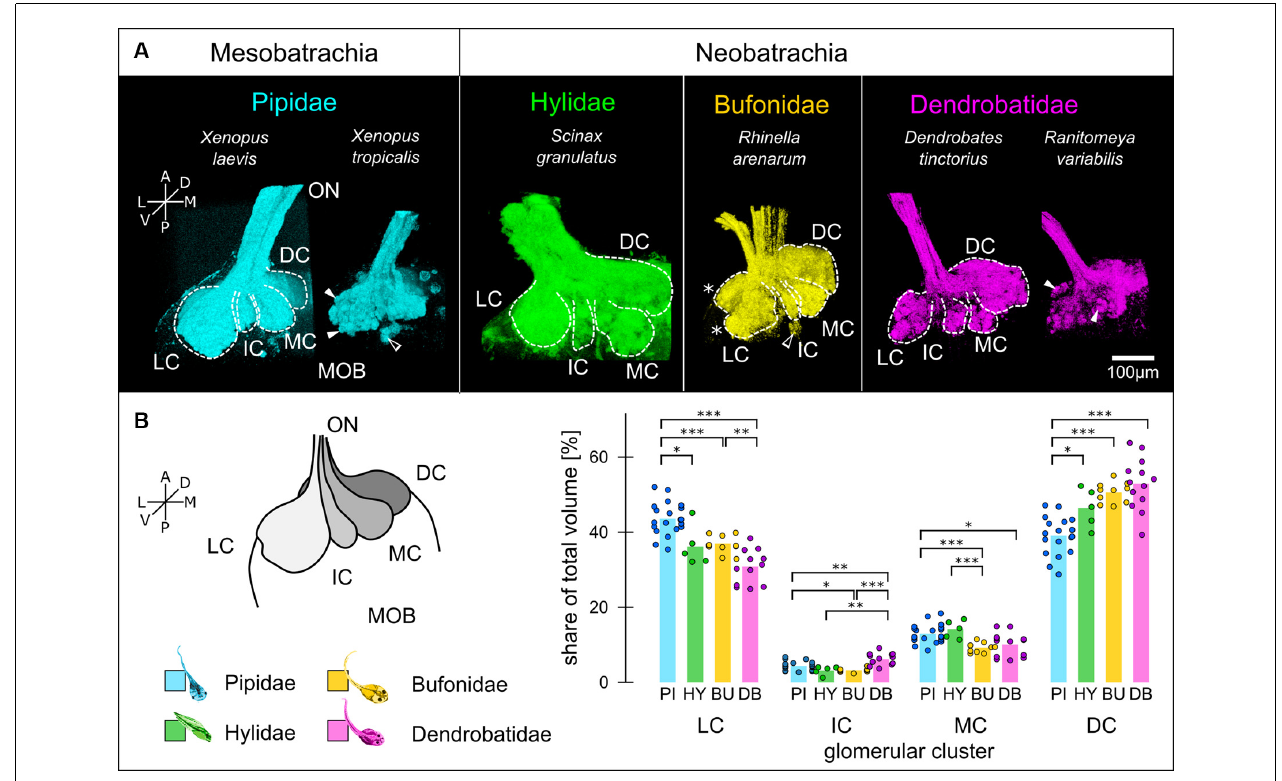
FIGURE 2 | Glomerular clustering in the MOB is conserved among anuran tadpoles. (A) Glomeruli in the MOB of all species can be segregated into three ventrally (LC, IC, MC) and one dorso-medially located clusters (DC). White dotted lines—cluster outlines, filled arrowheads—glomeruli, empty arrowhead—small glomerular cluster, asterisks—ventral and dorsal lobes of the LC. (B) The relative volume of the clusters (schematically shown on the left) varies between the four families. The volumes of the clusters relative to the total glomerular volume for each family are shown. Each dot represents one MOB hemisphere and species of the same family are grouped. Significance levels: ∗∗∗ p < 0.001, ∗∗ p < 0.01, ∗ p < 0.05. A, anterior; P, posterior; L, lateral; M, medial; D, dorsal; V, ventral; ON, olfactory nerve; MOB, main olfactory bulb; LC, lateral cluster; IC, intermediate cluster; MC, medial cluster; DC, dorsomedial cluster; PI, Pipidae; HY, Hylidae; BU, Bufonidae; DB,